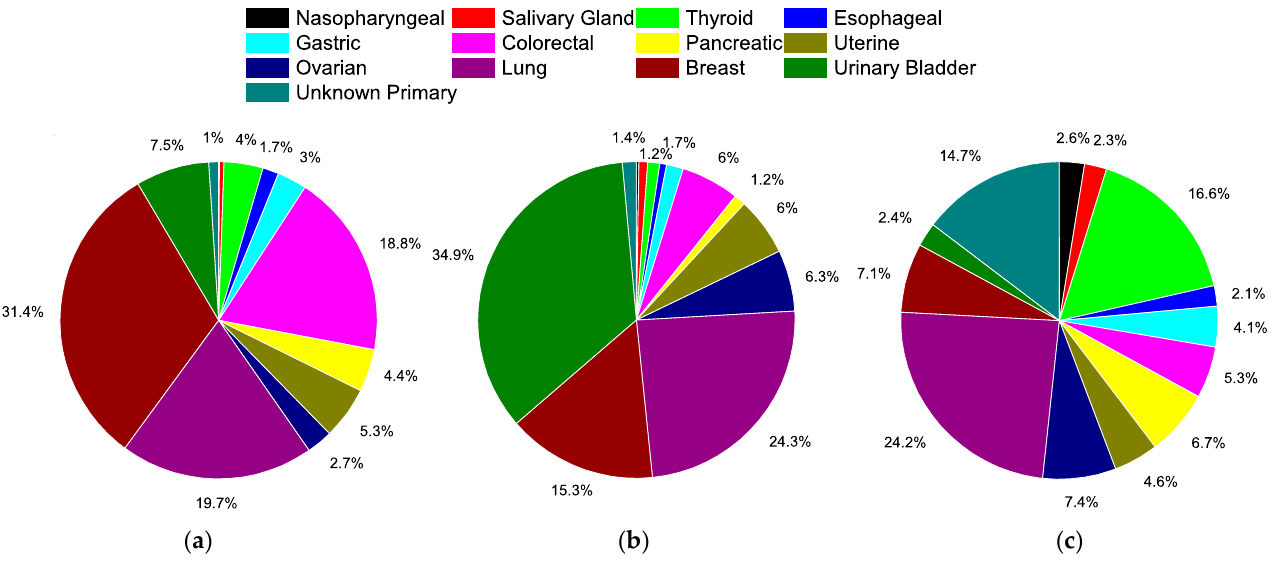
Figure 1. Distribution of cancers by site analyzed in SEER, 1975–2017. ( a ) All cases by sites examined, totaling 5.1 million cases. ( b ) All undifferentiated cases with defined histological subtype by site examined, totaling 252,930 cases. ( c ) All undifferentiated carcinomas by site examined totaling 11,292 cases. Data labels represent percentages, and markers are omitted if less than 1%.